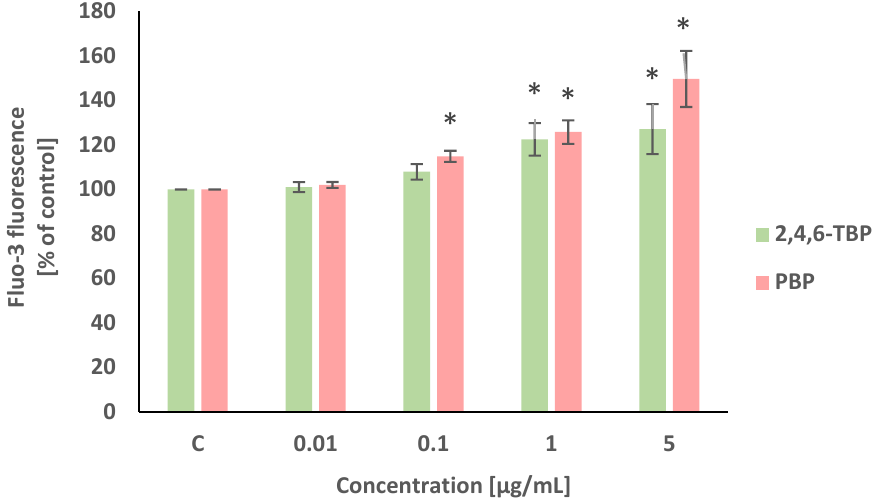
Figure 2. Changes in intracellular calcium ion levels in human PBMCs incubated with 2,4,6-TBP and PBP in concentrations ranging from 0.01 to 5 µg/mL for 24 h. Means ± SDs were calculated from four individual experiments (four blood donors). Results were statistically different from negative control at * p < 0.05. Statistical analysis was conducted using one-way ANOVA and a posteriori Tukey test.